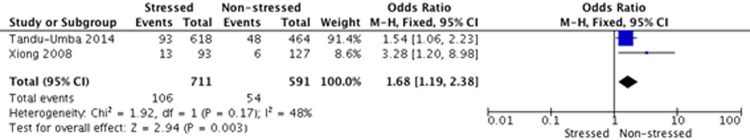
Meta-analysis of low birth weight.